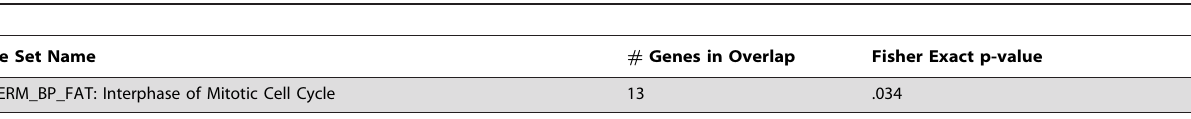
Table 5. Gene Set Enrichment Analysis of Micro-aberrant